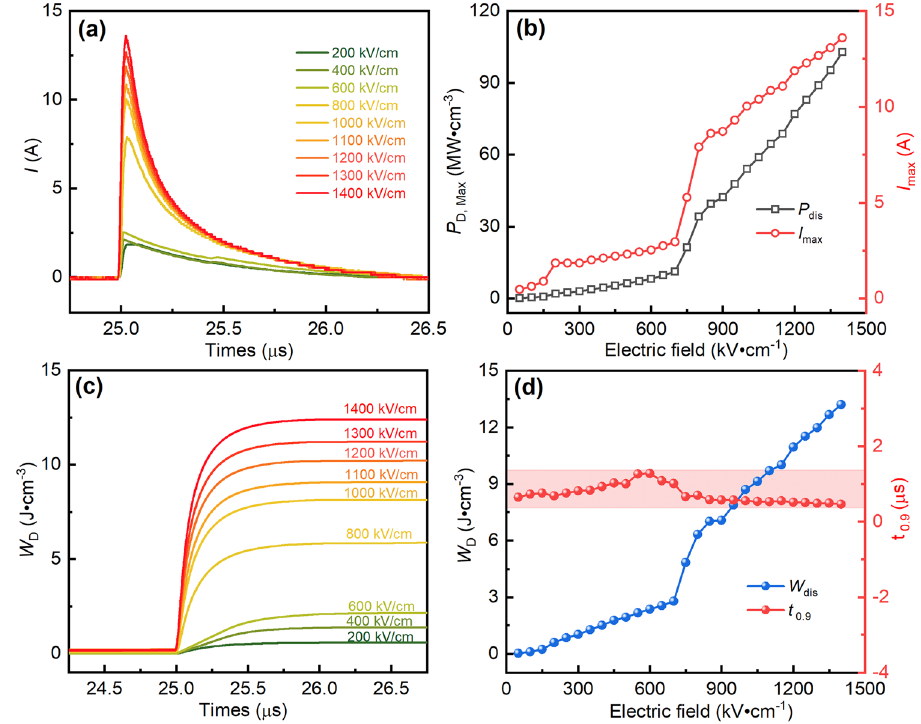
Fig. 7 | Charge/discharge performance of SANT MLCCs. Overdamped discharge current wave of SANTMLCCsatdifferent electric fi elds( a ),the evolutionof P D, Max